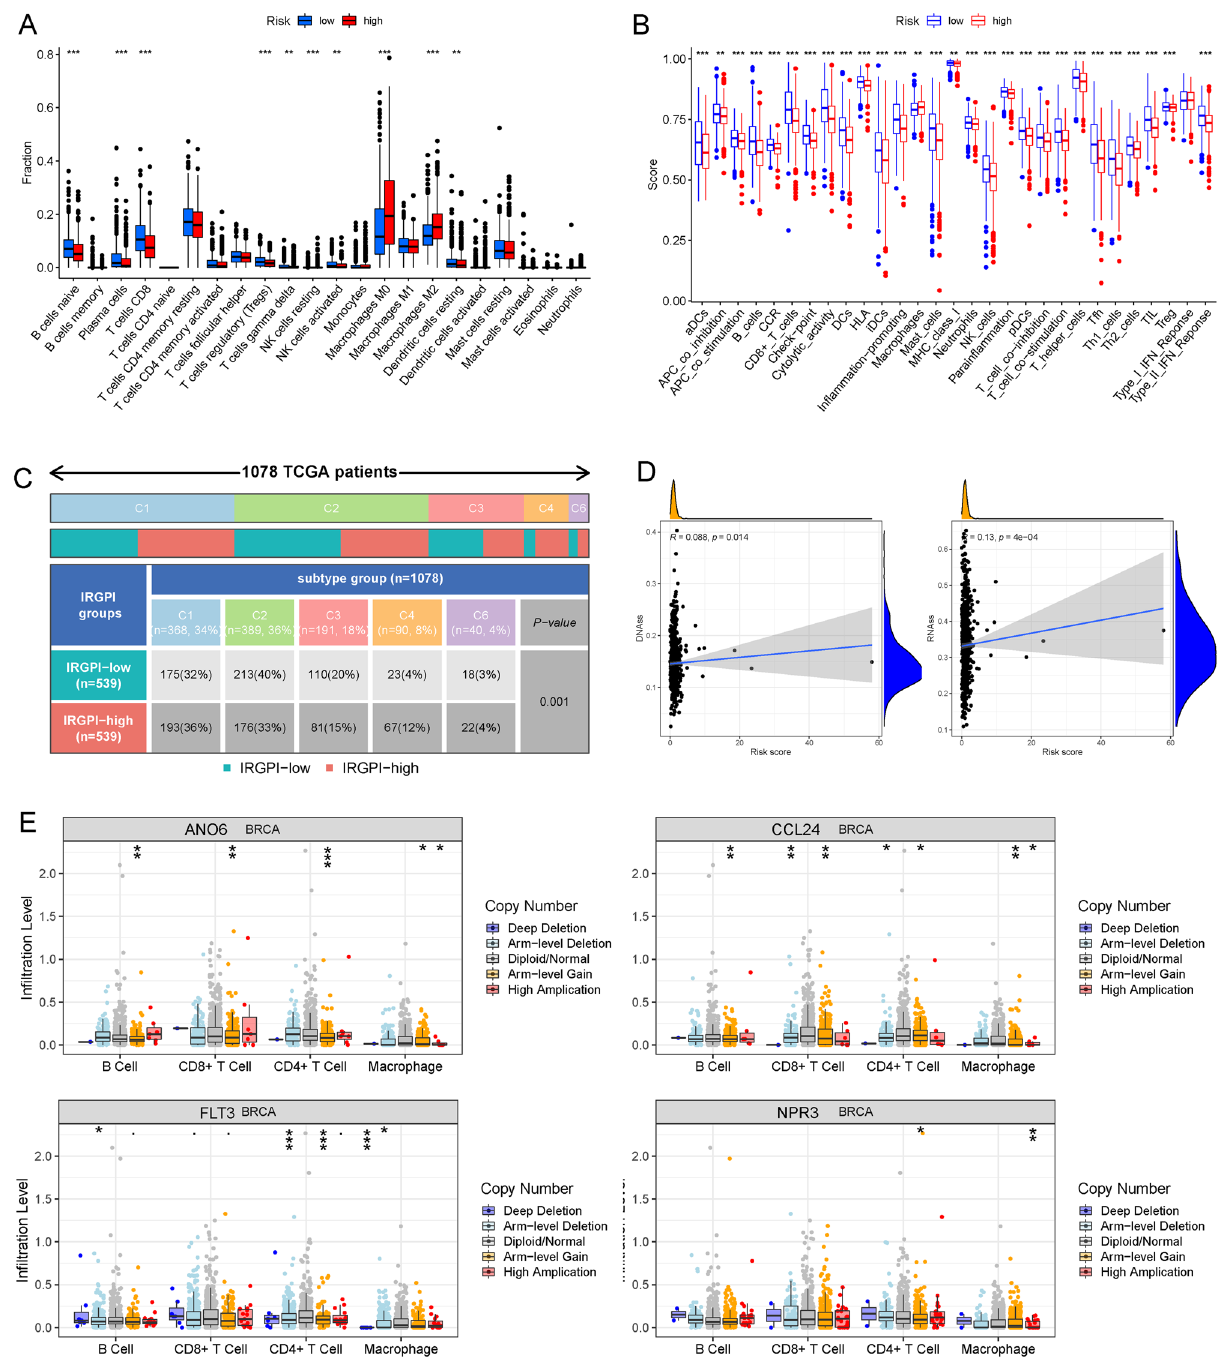
Figure 8. Patients with high- and low-risk scores had different immune statuses. Comparison of the single- sample gene set enrichment analysis (ssGSEA) scores of 22 types of immune cells ( A ) and 13 immune-related pathways ( B ) between low- (blue box) and high-risk (red box) groups in The Cancer Genome Atlas (TCGA) project. ( C ) Immune-related gene prognostic index (IRGPI) differed among subtypes in the high and low-risk groups. ( D ) The tumour stemness of breast cancer (BC) patients between the high- and low-risk groups. ( E ) The relationship between copy number variations (CNVs) of 4 immune-related genes (IRGs) (ANO6, CCL24, FLT3, and NPR3) and the level of infiltration of B cells, T cells, and macrophages in BC. *P < 0.05; **P < 0.01; ***P < 0.001. ssGSEA single-sample gene set enrichment analysis, TCGA The Cancer Genome Atlas, IRGPI immune-related gene prognostic index, BC breast cancer, CNV copy number variation, IRG immune-related